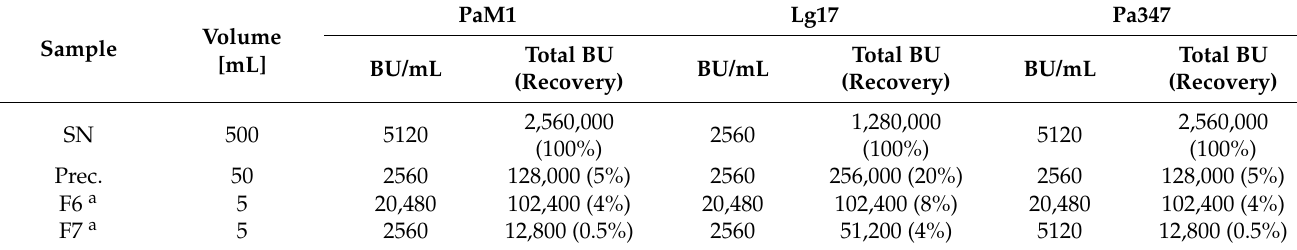
Table 1. Antimicrobial activity in samples of different steps of the purification of antimicrobial compounds of P. acidilactici M1 (PaM1), L. garvieae 17 (Lg17), or P. acidilactici 347 (Pa347). SN: spent culture supernatants; prec.: ammonium sulfate- precipitated supernatant proteins; F6, F7: fractions 6 and 7 of the elution step of cation exchange chromatography of precipitated supernatant proteins shown in Figure 4. Activity was calculated as BU/mL based on the highest dilution showing at least 50% of growth inhibition in the experiment shown in Figure 4. Total activity in each sample (total BU) was calculated using the BU/mL values and the total volume of each sample. Additionally, the recovery in % of the total activity of the entire supernatant of each culture is